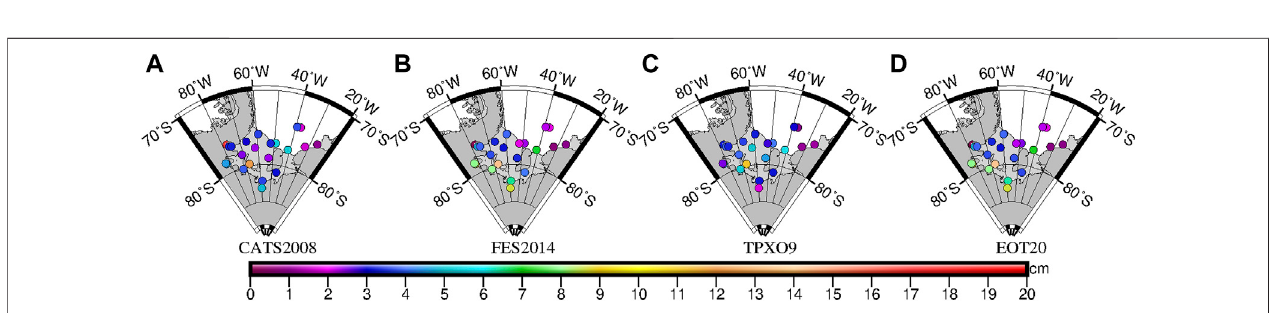
FIGURE 7 | RSS of each station in the Weddell Sea and FRIS of (A) CATS2008, (B) FES2014, (C) TPXO9, and (D) EOT20.